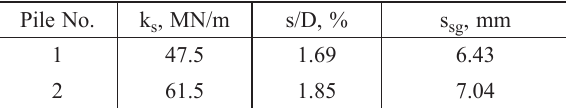
Table 6. Pile stiffness from the pile load test in the elastic stage Pile No.